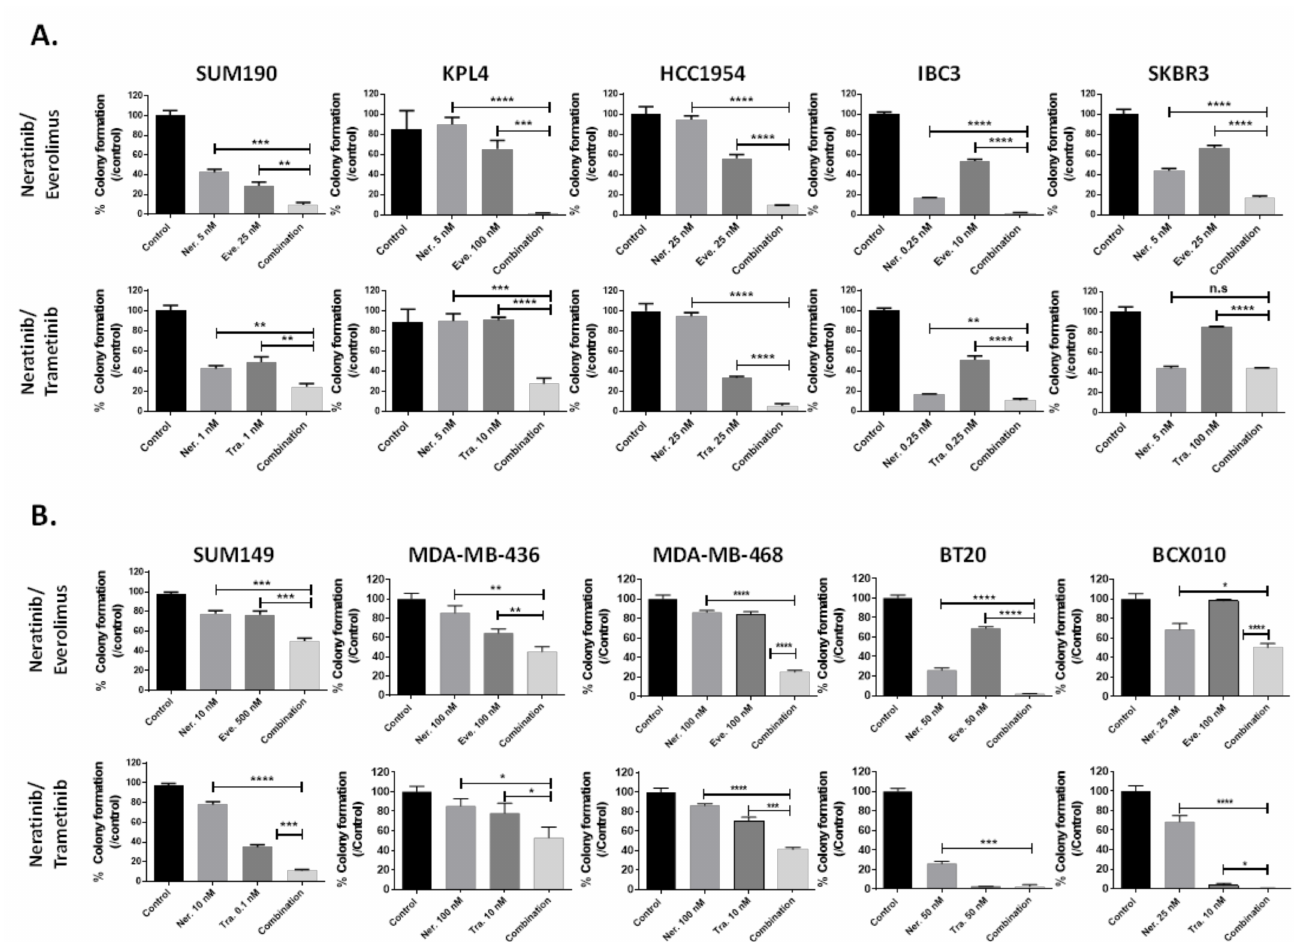
Figure 3. PI3K and MAPK pathway inhibitors enhanced the efficacy of neratinib in TNBC and HER2+ breast cancer cell lines. ( A ). Neratinib single-agent and combination therapy efficacy in HER2+ breast cancer cell lines. ( B ). Neratinib single-agent and combination therapy efficacy in TNBC cell lines. Each box shows mean ± s.d. n.s., not significant; *, p < 0.05; **, p < 0.01; ***, p < 0.001; ****, p < 0.0001. Experiments were repeated in